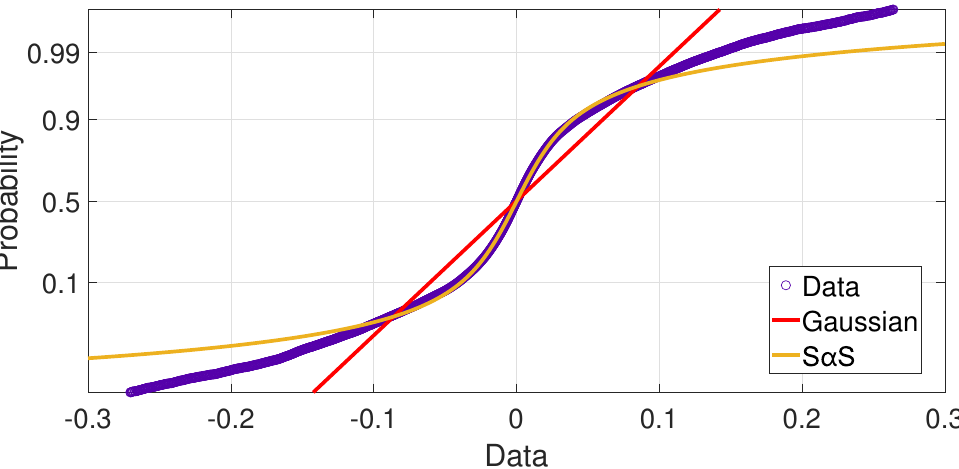
Figure 16. Outdoor scenario: Comparison between the data distribution and the estimated Gaussian and S α S